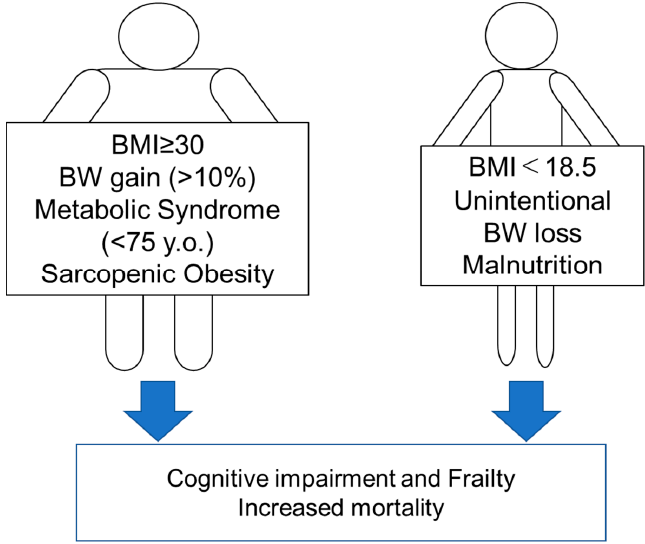
Figure 2. Nutritional states that are not preferred in older patients with diabetes for the prevention of cognitive impairment, frailty, and increased mortality. BMI, body mass index; BW, body weight.